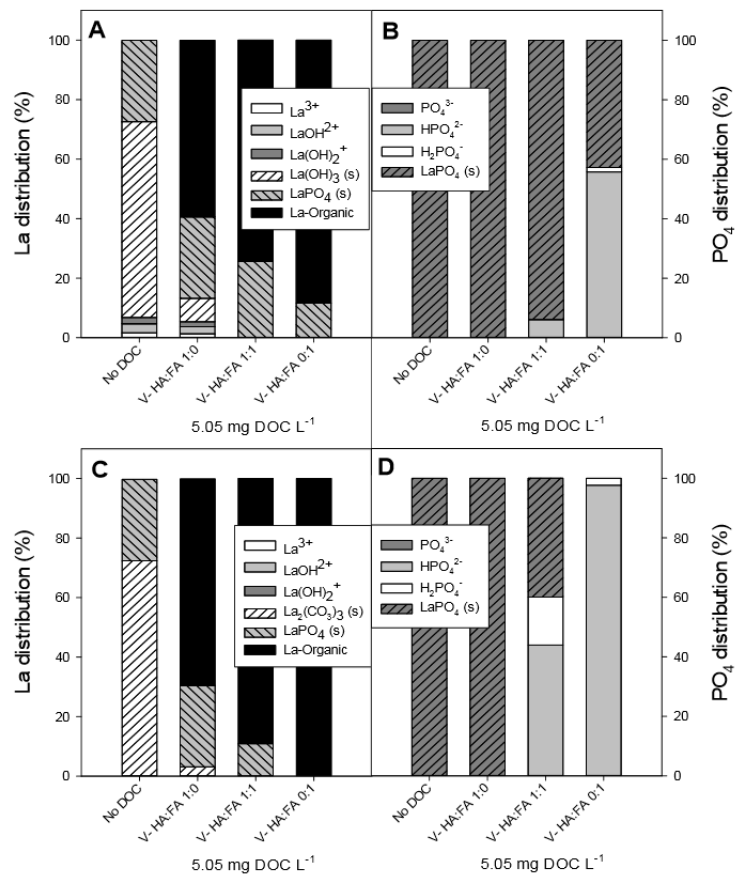
Figure 6. Results of chemical equilibrium modeling using the program CHEAQS Pro (version 2010.3), giving the distributions of La (Panel A ) and P (Panel B ) at no DOC or 5.05 mg L − 1 DOC as 100% humic acid (HA:FA 1:0), 50% humic acid and 50% fulvic acid (HA:FA 1:1), or 100% fulvic acid (HA:FA 0:1), whereas the same evaluations for La (Panel C ) and P (Panel D ) are given in the presence of 50 mg L − 1 carbonate. Simulations were run at pH = 7.57, La = 2846.5 µ g L − 1 , and phosphate = 173.5 µ g L − 1 , corresponding to the conditions in the treated